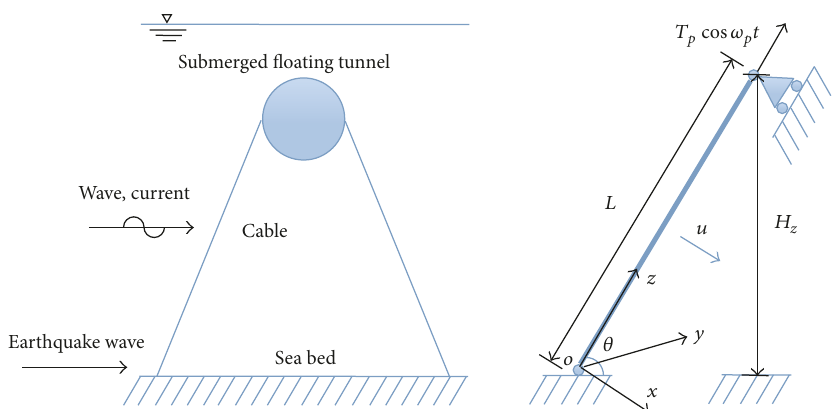
Figure 1: Definition sketch of the submerged floating tunnel model and its cable coordinate